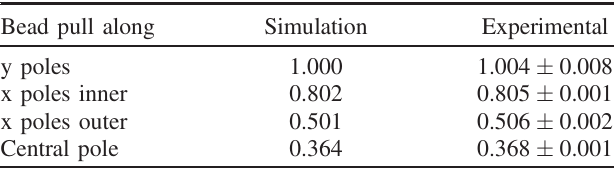
TABLE I. Comparison between simulation and experimental measurements of E through the different beam pipe locations. z Bead pull along Simulation